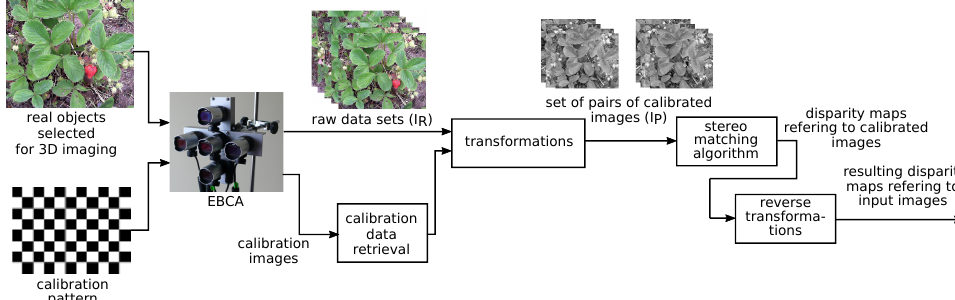
Figure 4. The process of stereo matching using pairwise